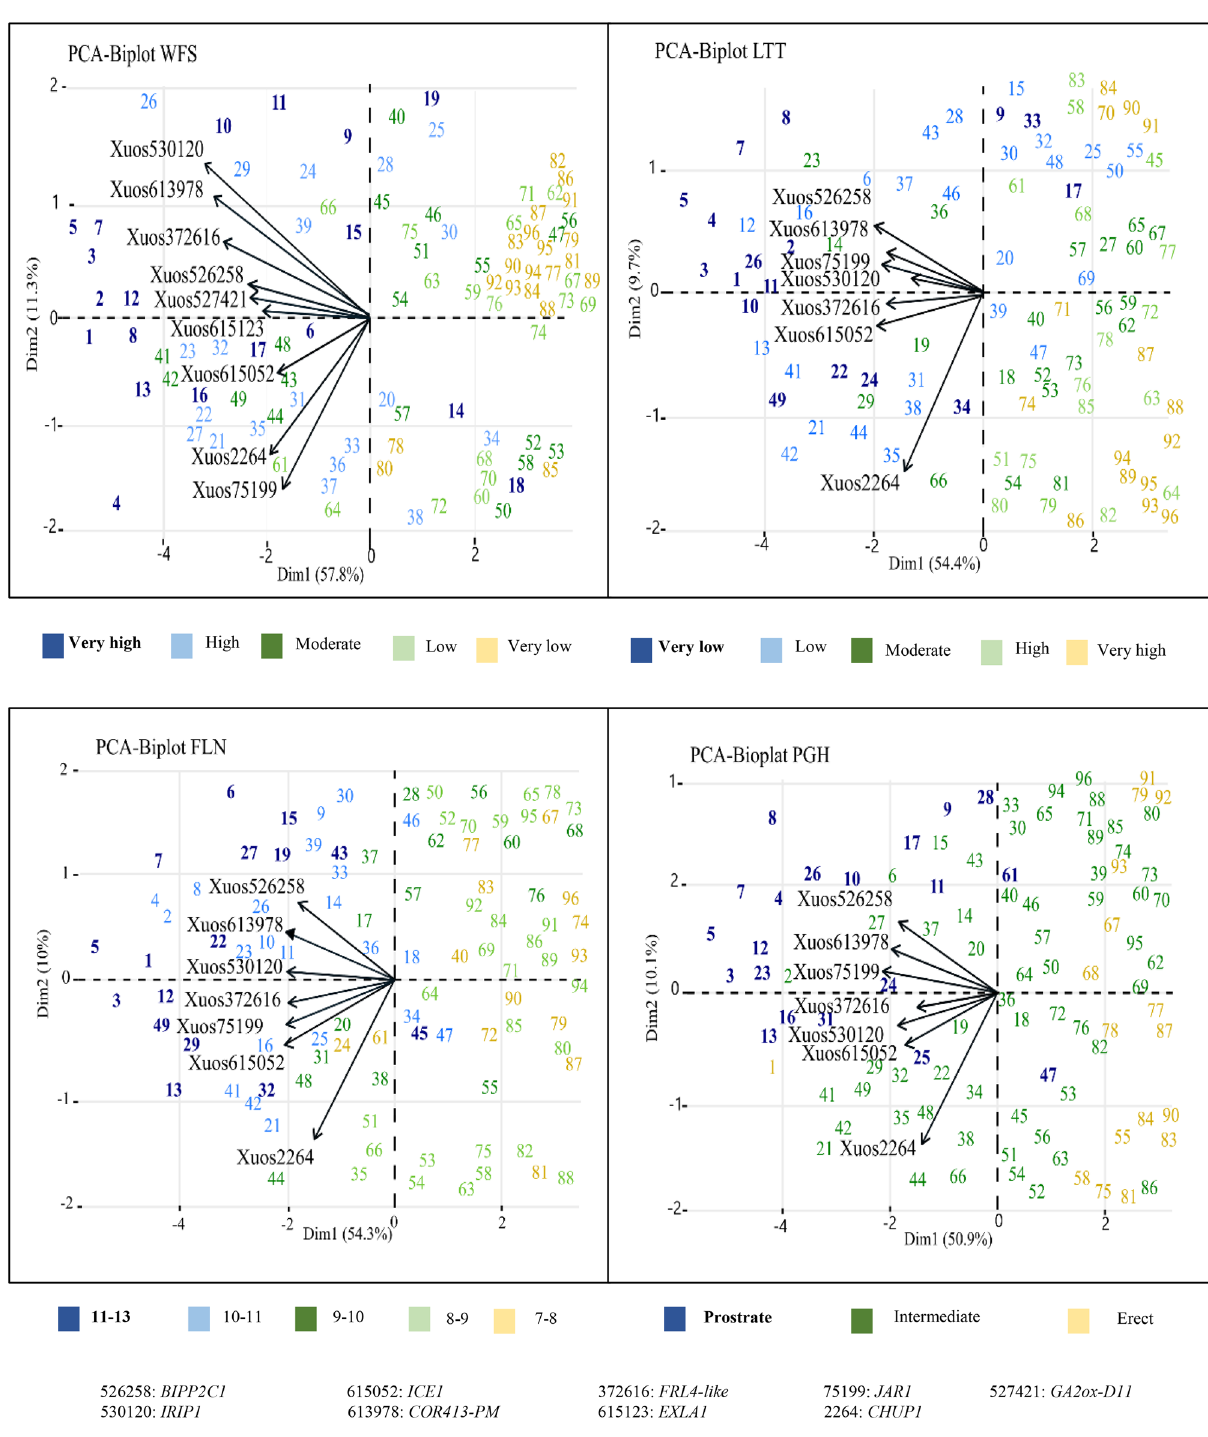
Figure 3. PCA bi-plot visualizing SNP effects on four traits analyzed for rye population of 96